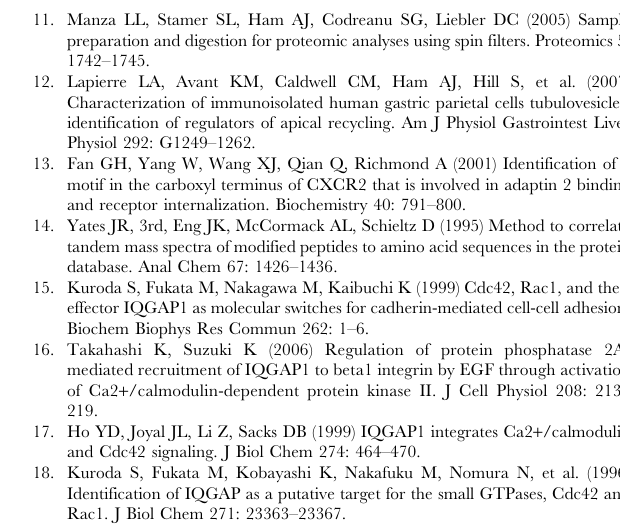
Figure S1 No inhibition of IQGAP1-CXCR2 association when IQGAP1 1-160 fragment expressing in HEK-293 CXCR2 cells. HEK293-CXCR2 cells were transiently transfected with either vector control or IQGAP1 1-160 expression construct. Cells were stimulated with either CXCL8 (100 ng/ml) or carrier buffer for 5 min at 37 u C and co-immunoprecipitation was performed with anti- CXCR2 antibody conjugated to sepharose beads and immunoblotted with anti-IQGAP1 or CXCR2 antibody. Experiments were performed three times with similar results. (TIF) Figure S2 No inhibition of IQGAP1-CXCR2 association in the presence of large amount of IQGAP1 1-160 fragment added in vitro in dHL-60 cells. Differentiated HL-60 cells were lysed in lysis buffer (0.1% triton X-100 in PBS). Co-immunoprecip- itation with anti-CXCR2 antibody was performed in the presence of a large amount of IQGAP1 fragment 1-160 amino acids (20 or 40 mg) or the non-competitive control fragment IQGAP1 161-431 or buffer only. IQGAP1 and CXCR2 were detected by immunoblot with anti- IQGAP1 or CXCR2, respectively. Experiments were repeated at least three times with similar results.